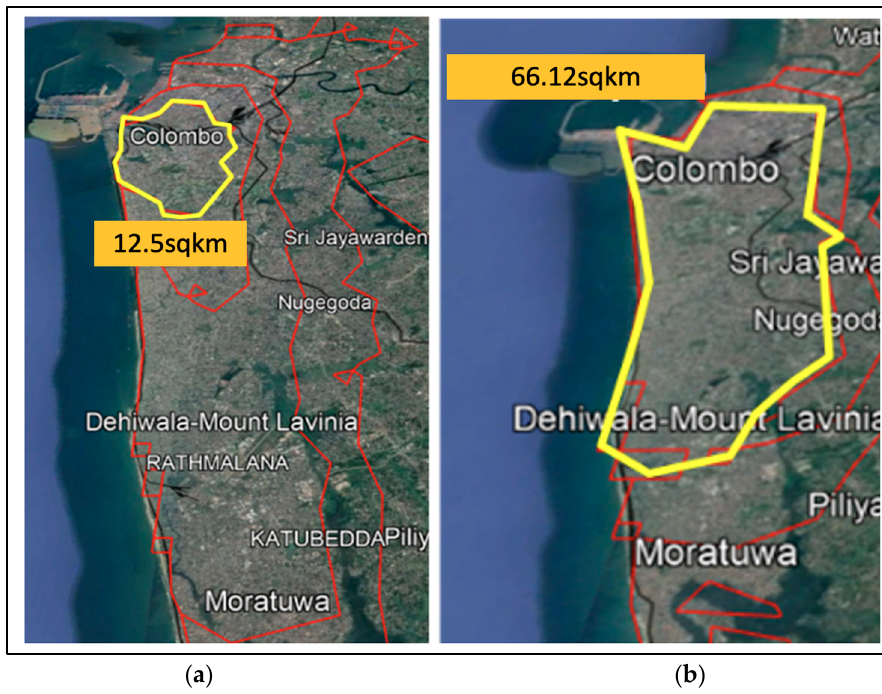
Figure 9. Exemplary demonstration of changing agglomeration footprints: ( a ) urban form; ( b ) urban function. Table 9. Urban centers and the expansion